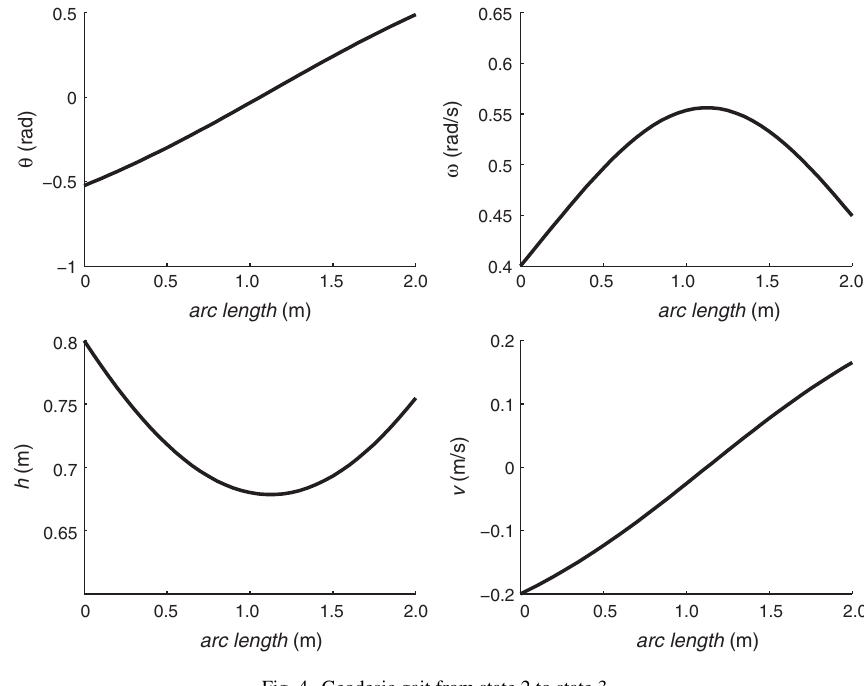
Fig. 4. Geodesic gait from state 2 to state 3.